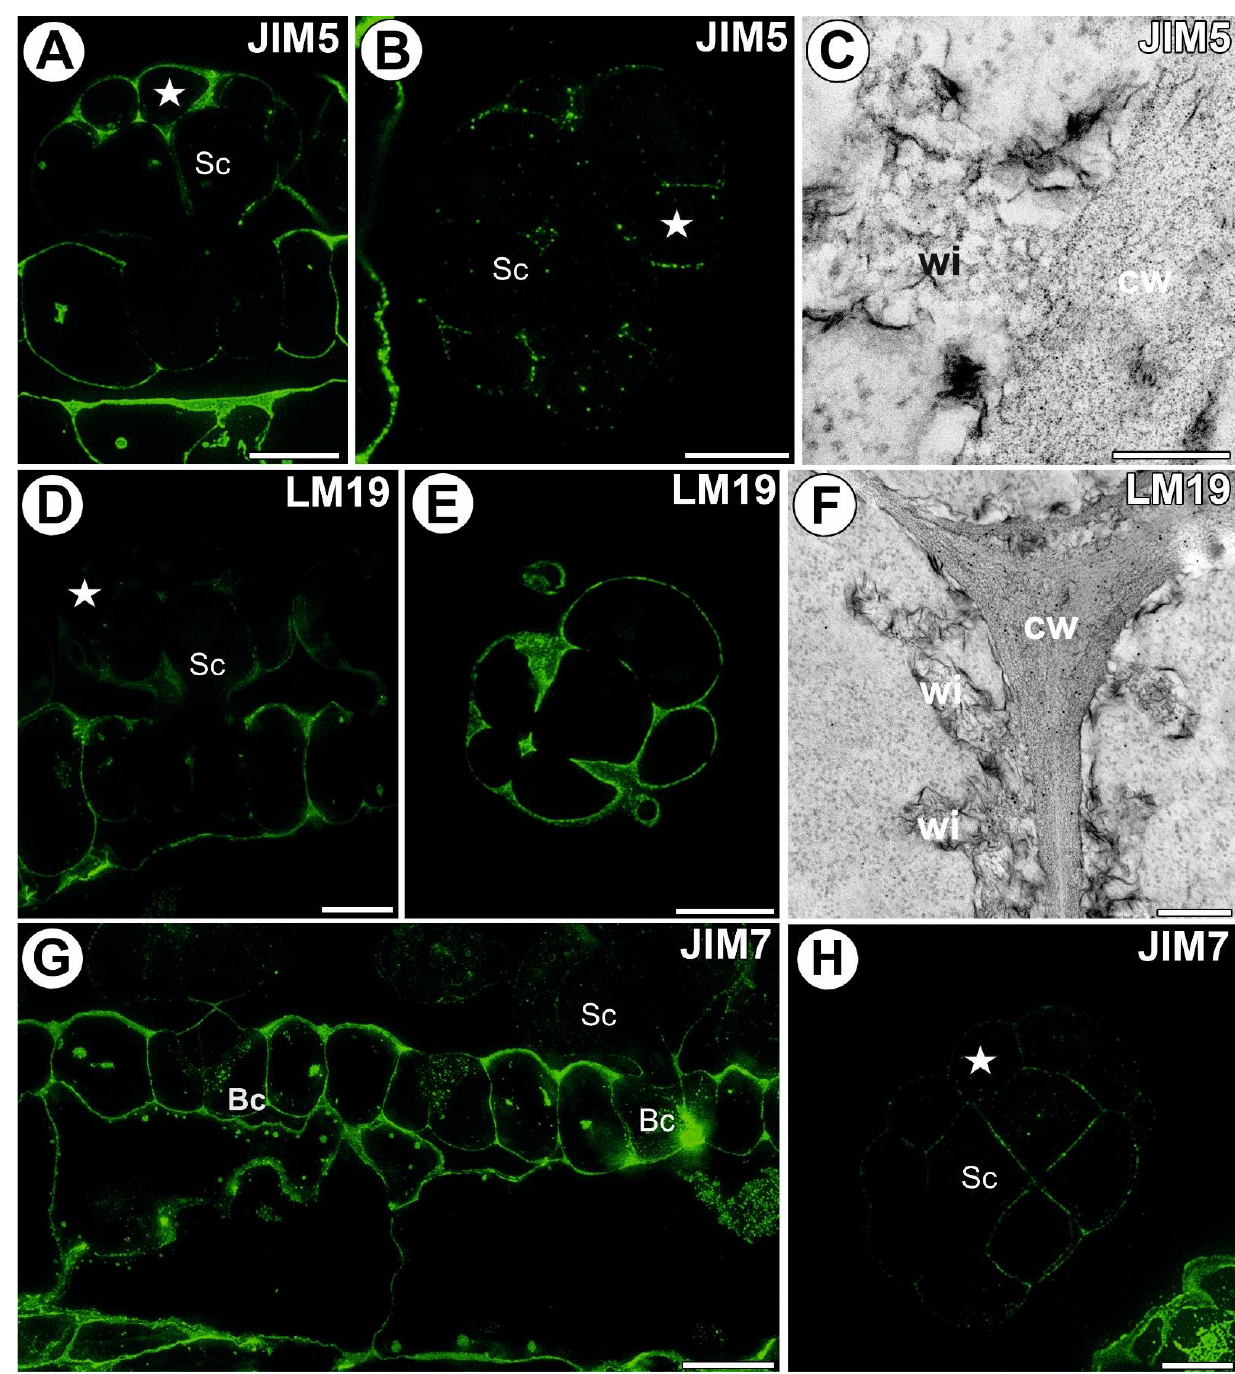
Figure 3. Homogalacturonans detected in the A. vesiculosa trap. ( A ) HG (labeled with JIM5) detected in the gland; secretory cell (star), stalk cell (Sc), basal cell (Bc), bar 10 µ m. ( B ) HG (labeled with JIM5) detected in the gland, transverse section; secretory cell (star), stalk cell (Sc), bar 10 µ m. ( C ) HG (labeled with JIM5) detected in the gland, wall ingrowths (wi), cell wall (cw), bar 200 nm ( D ) HG (labeled with JIM19) detected in the gland; secretory cell (star), stalk cell (Sc), basal cell (Bc), bar 10 µ m. ( E ) HG (labeled with JIM19) detected in the gland, transverse section; bar 10 µ m. ( F ) Immunogold labeling of wall ingrowths with JIM19 in the glandular cells; wall ingrowths (wi), cell wall (cw); bar 300 nm. ( G ) HG (labeled with JIM7) detected in the glands and trap wall; secretory cell (star), stalk cell (Sc), basal cell (Bc), bar 10 µ m. ( H ) HG (labeled with JIM7) detected in the gland, paradermal section; secretory cell (star), stalk cell (Sc), bar 10 µ